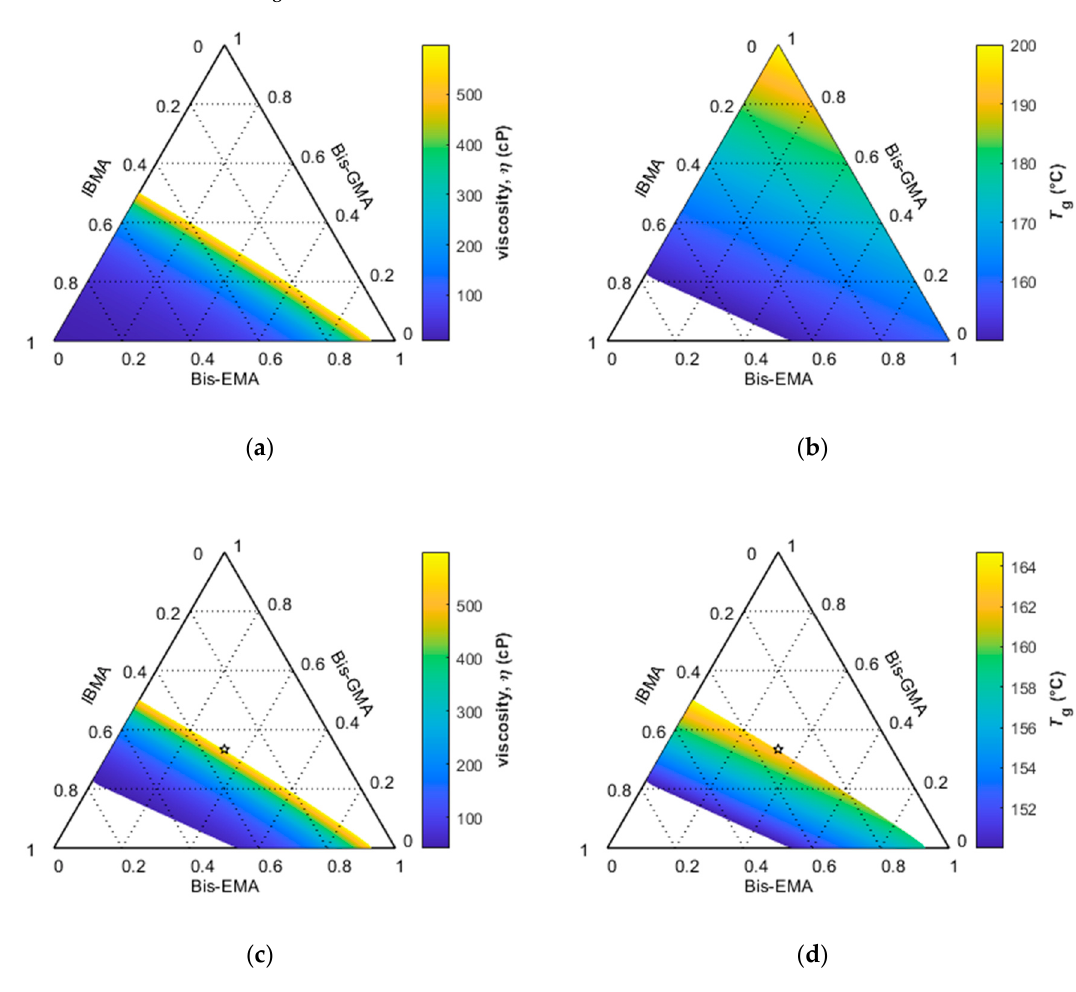
Figure A1. Ternary plots of predicted viscosity and T g as functions of changing composition of Bis-GMA / Bis-EMA / IBMA system; the axes are weight percentages, and values are represented by color. ( a ) Predicted viscosity lower than 600 cP; ( b ) predicted T g higher than 150 °C; ( c , d ) predicted overlap area where viscosity is lower than 600 cP and T g is higher than 150 °C. The star in ( c , d ) marks the DA-1 composition.